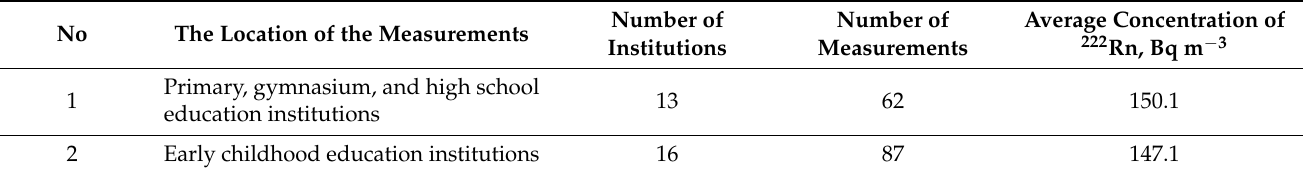
Table 1. The average concentration of radon in early education institutions and primary, gymna-